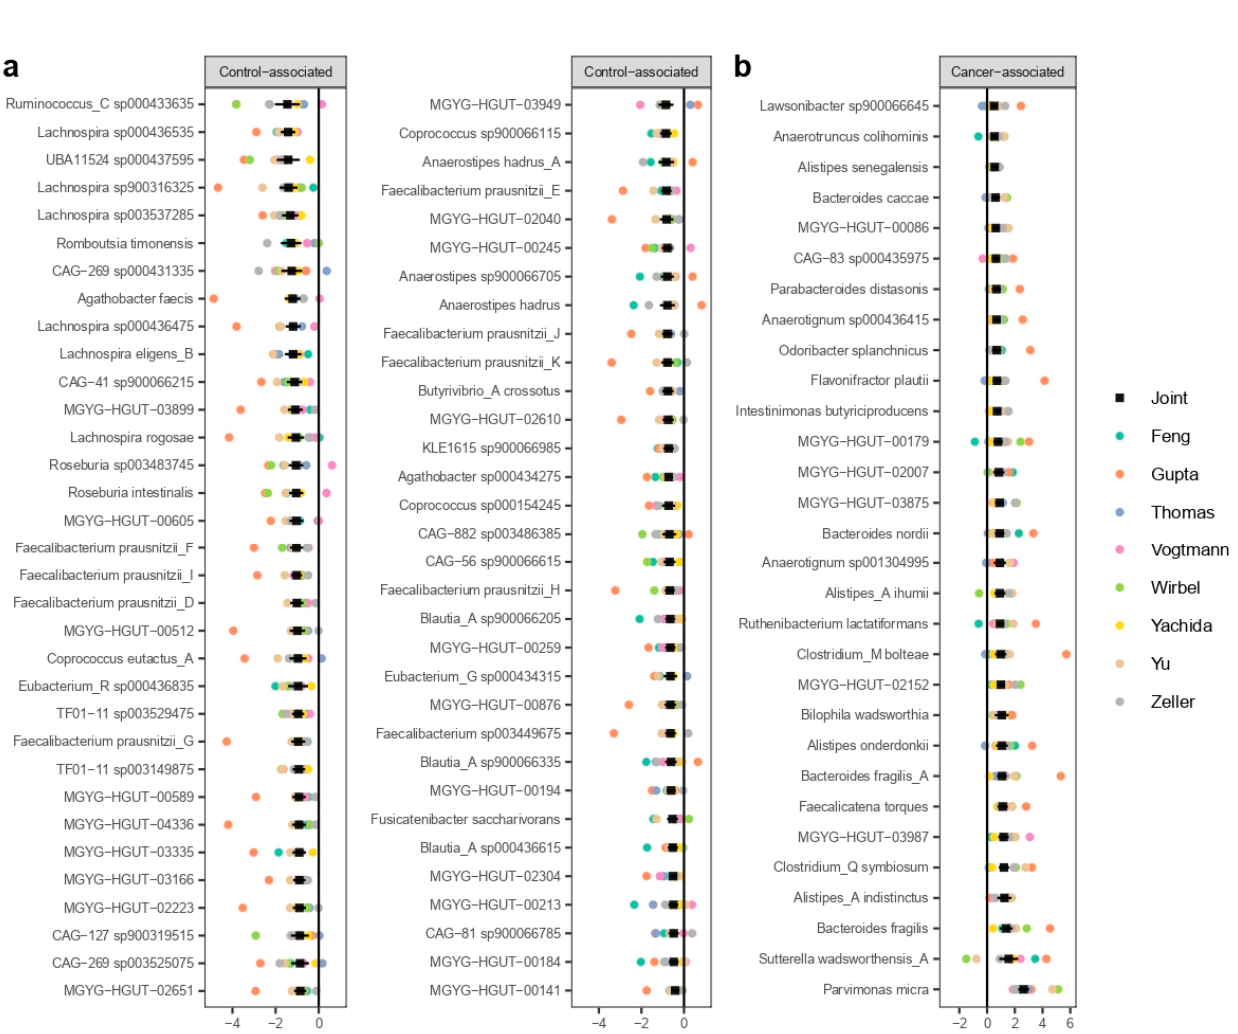
Figure 2. Species that were statistically associated to CRC. Black squares with lines represents the estimate of the effect size and 95% confidence intervals. The colored dots represent the estimates of the effect sizes for each dataset. ( a ) Species that were found to be decreased in cancer (columns 1 and 2). ( b ) Species that were found to be increased in cancer (column 3).